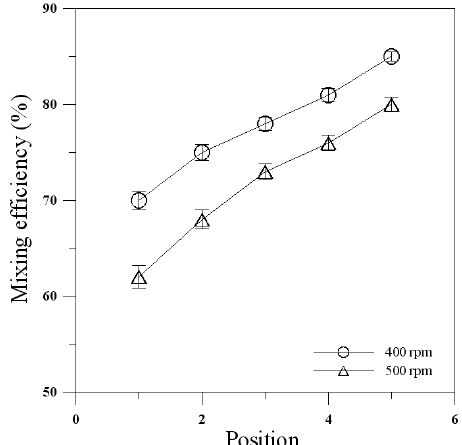
Fig. 6 Comparison of mixing efficiency along U-shaped channel for Ω = 400 and 500